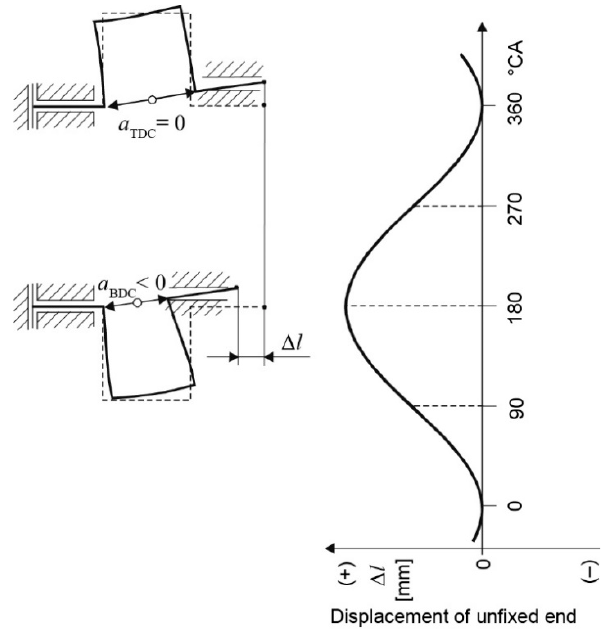
Figure 6. Model of the crank of the unilaterally fixed crankshaft (with one crank) and displacement of